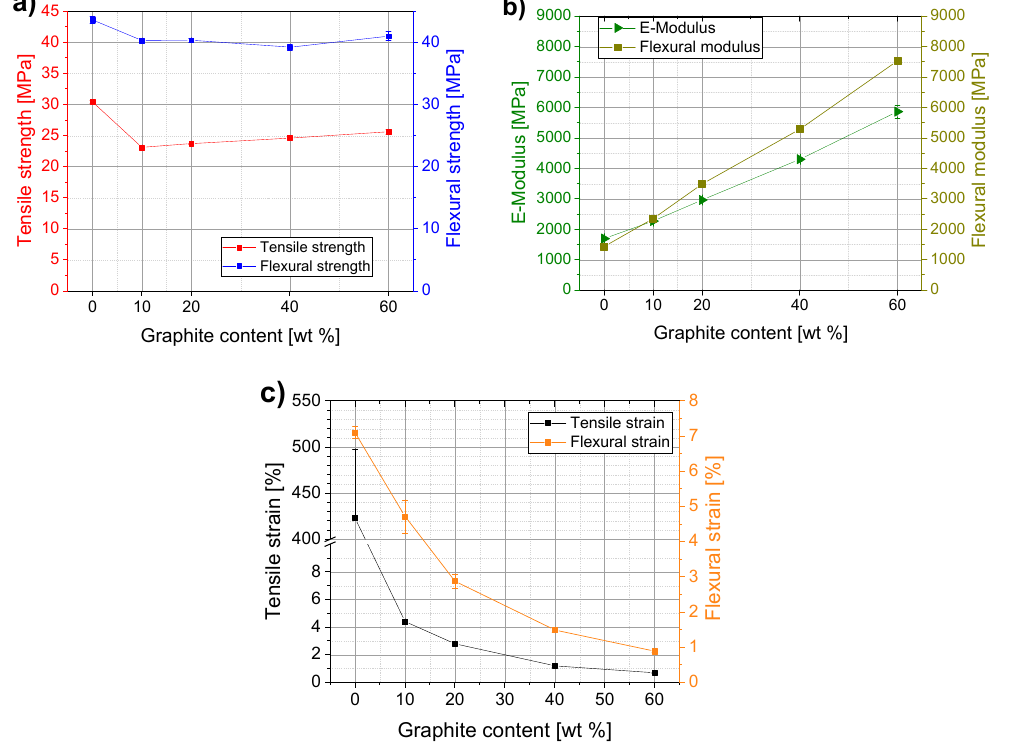
Figure 1. Mechanical properties of PP/graphite composites depending on filler content: ( a ) tensile and flexural strengths; ( b ) E-Modulus and flexural modulus; ( c ) tensile strain at break and flexural strain at maximal stress.